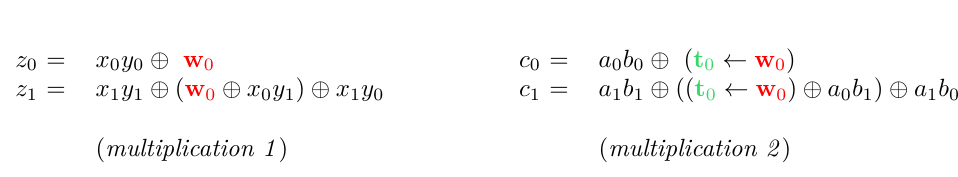
Figure 1: RRM scheme applied on two 1st-order secure ISW multiplications, generating random element w 0 in multiplication 1 and recycling it in multiplication 2.